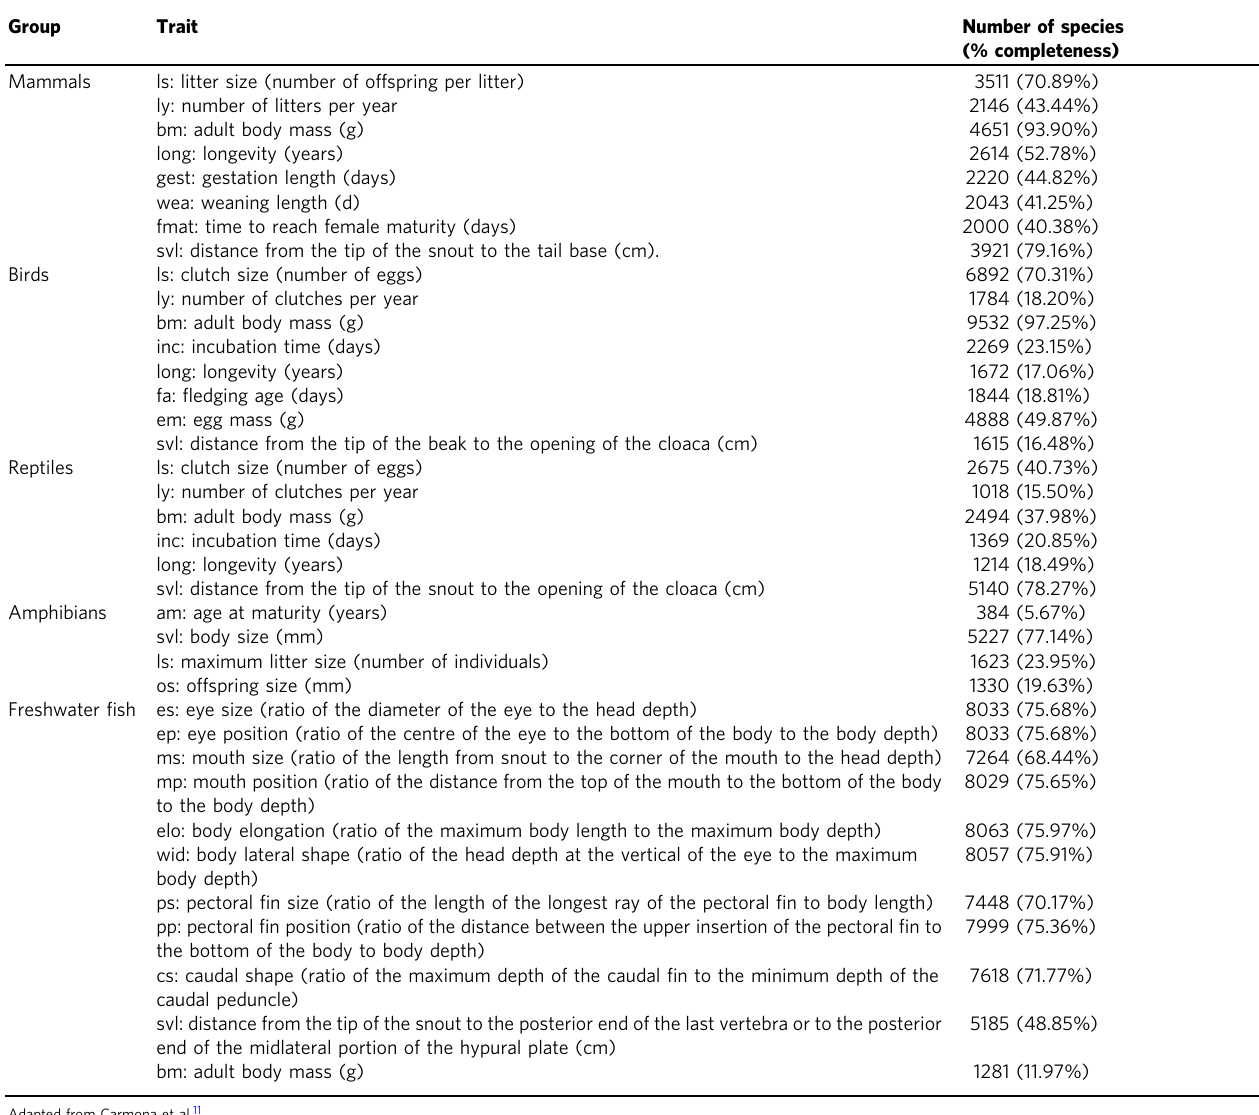
Table 1 Functional traits considered in each group. Group Trait Number of species